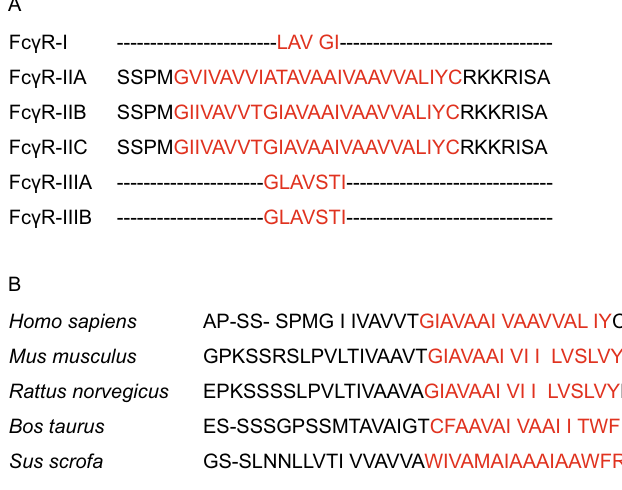
Figure 5. An alignment of the transmembrane domain of Fc γ receptors. (A) Shown are alignments of the transmembrane domain sequences of low af fi nity Fc γ receptors in NCBI. The conserved regions are highlighted in red color. (B) Shown are alignments of the transmembrane domain sequences from different species that are available in NCBI. The conserved regions are highlighted in